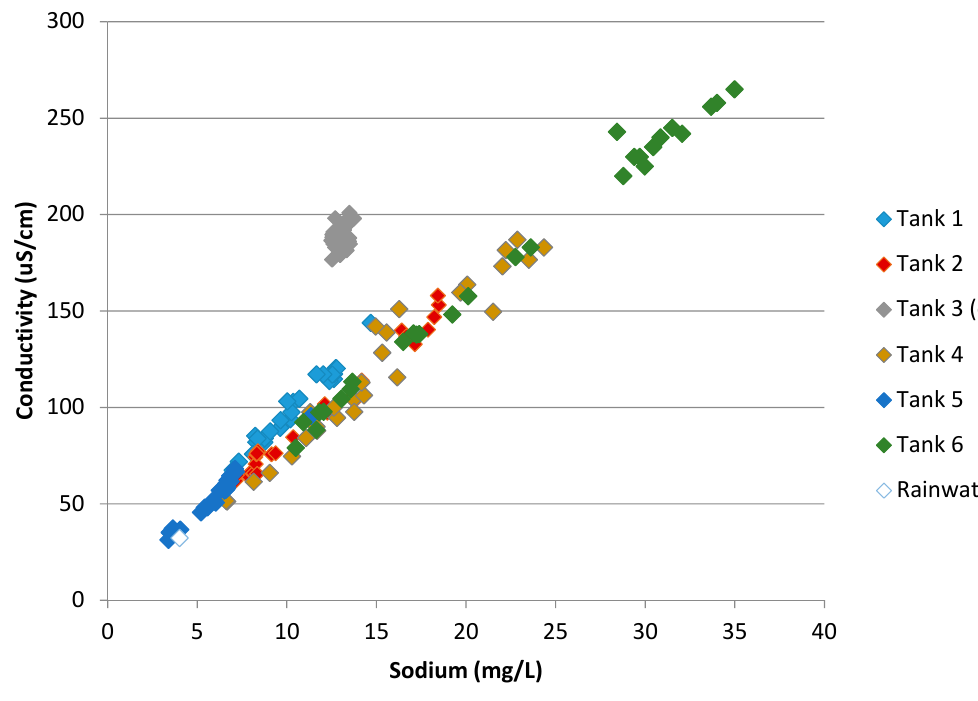
Figure 5. Sodium and conductivity data for all samples.